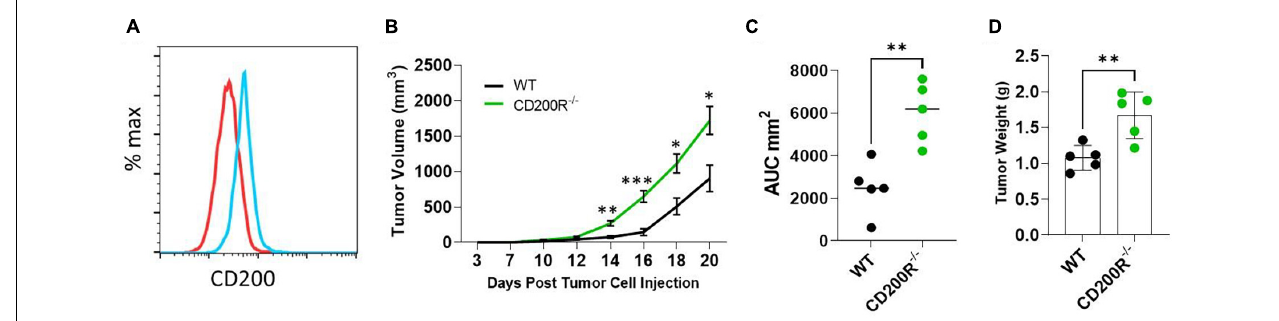
FIGURE 1 | Accelerated growth of Yumm1.7 melanoma tumors in CD200R − / − mice. (A) Flow cytometry analysis of CD200 expression in Yumm1.7 cells. Red line represents isotype antibody control, blue line represents cells stained with CD200 Antibody. (B) Tumor growth kinetics. Yumm1.7 cells were injected into each mouse subcutaneously at a dose of 5 × 10 5 /mouse. Tumor growth was monitored by measuring tumor length and width every 2 days after the appearance of tumors. Growth kinetics (changes of mean tumor volume over time) are shown. ∗∗ P = 0.0012; ∗∗∗ P = 0.00067; ∗ P = 0.0101 on day 18; ∗ P = 0.0017 on day 20. (C) Area under the curve (AUC) was calculated based on the tumor volume data shown in B ( ∗∗ P = 0.0079). (D) Tumors isolated from wild type and CD200R − / − mice were weighted at the end of the experiment ( ∗∗ P = 0.0069). Data shown represents three experiments with similar results. Two sided Student’s t -test was used for the statistical